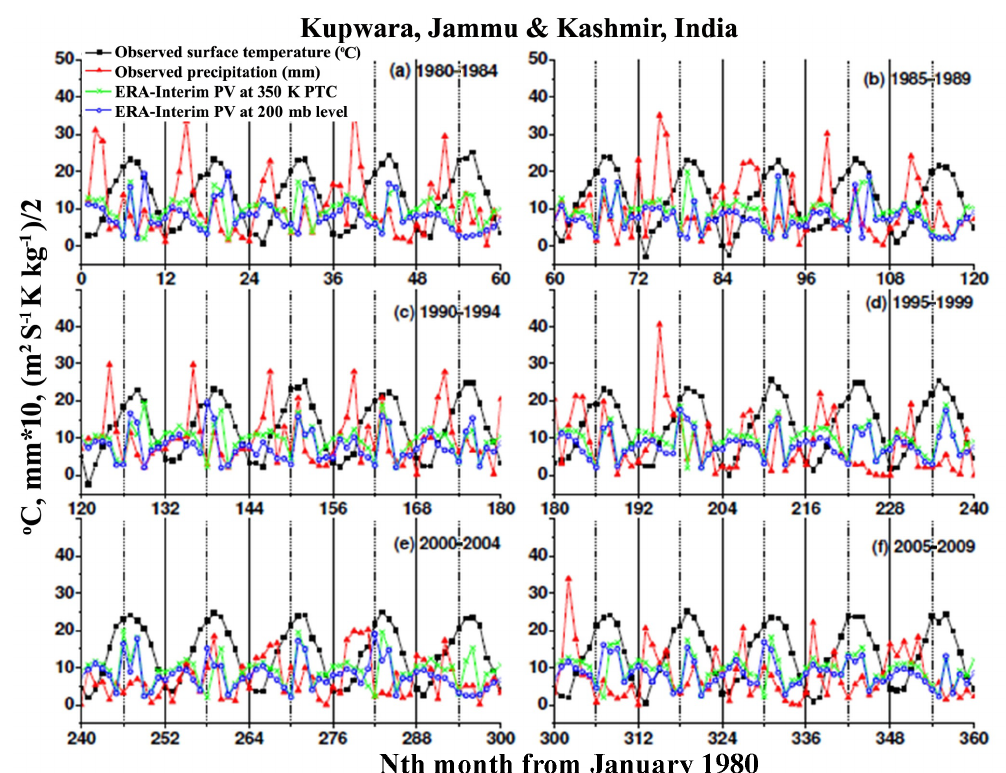
Figure 9. Same as Fig. 7 but for